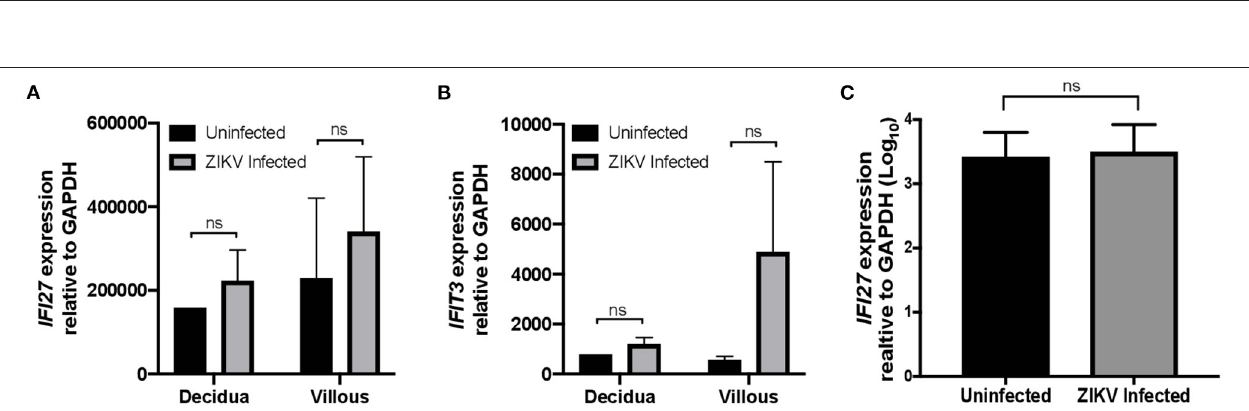
FIGURE 5 | IFI27 is highly expressed in CD14 + decidua and villous cells after ZIKV infection. Validation of increased expression of IFI27 in CD14 + decidua and villous cells collected from pregnant dams infected with ZIKV and uninfected controls from multiple study cohorts ( n = 6 per condition). RNA was isolated and gene expression analyzed by qRT-PCR of (A) IFI27 and (B) control IFIT3 relative to GAPDH. (C) RNA was isolate from the PBMCs of dams infected with ZIKV and uninfected controls from multiple study cohorts ( n = 12 per condition) and analyzed for IFI27 gene expression using GAPDH to normalize the data across samples. Student’s t -test was used to determine statistical significance of expression data obtained from infected and uninfected animals.